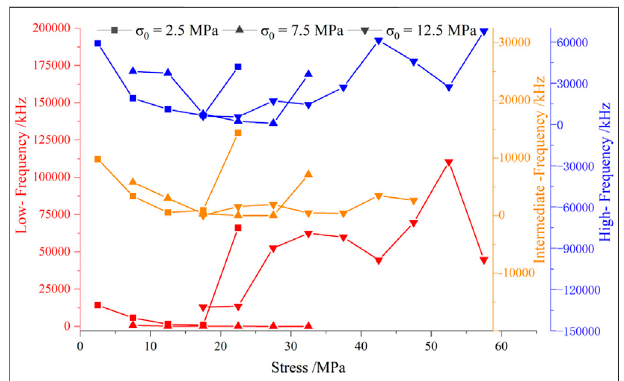
FIGURE 8 | Variation of frequency value with peak stress in each frequency band under different initial